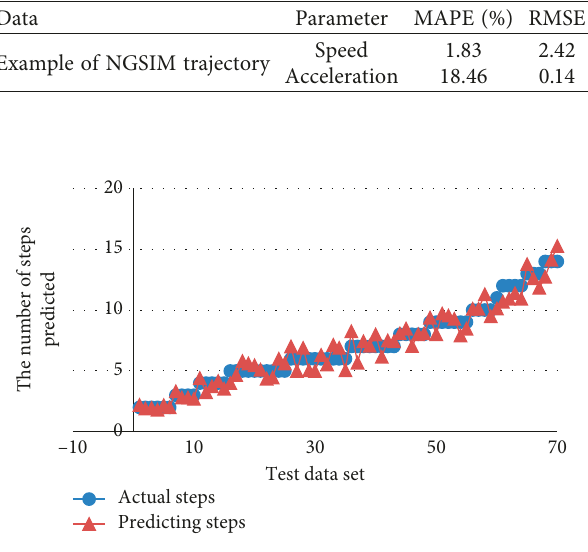
Figure 10: The test results of predictable step model.